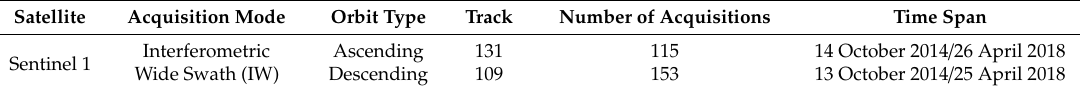
Table 1. Characteristics of the Synthetic Aperture Radar (SAR)